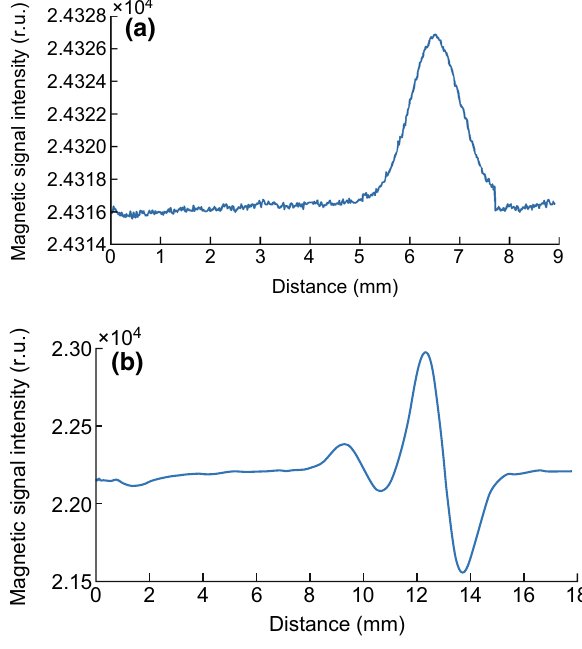
Fig. 4 a Waveform for a single coil employed as the induction coil in the first version of the MIR. b Waveform for a pair of coils employed as the induction